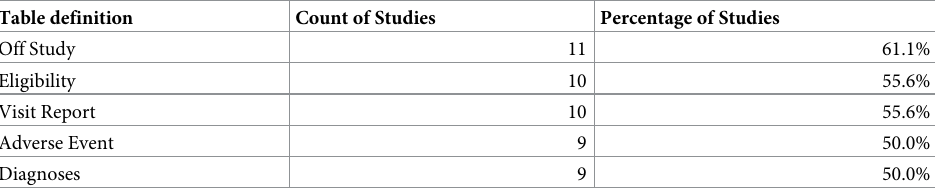
Table 6. Very common form names and the number and percentage of studies their used